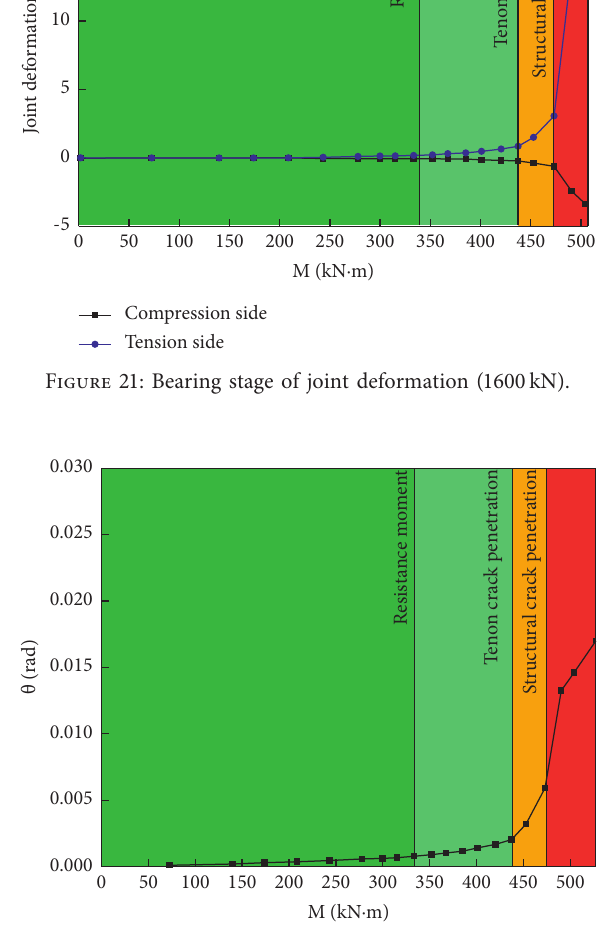
Figure 22: Bearing stage of joint deformation (1600kN).